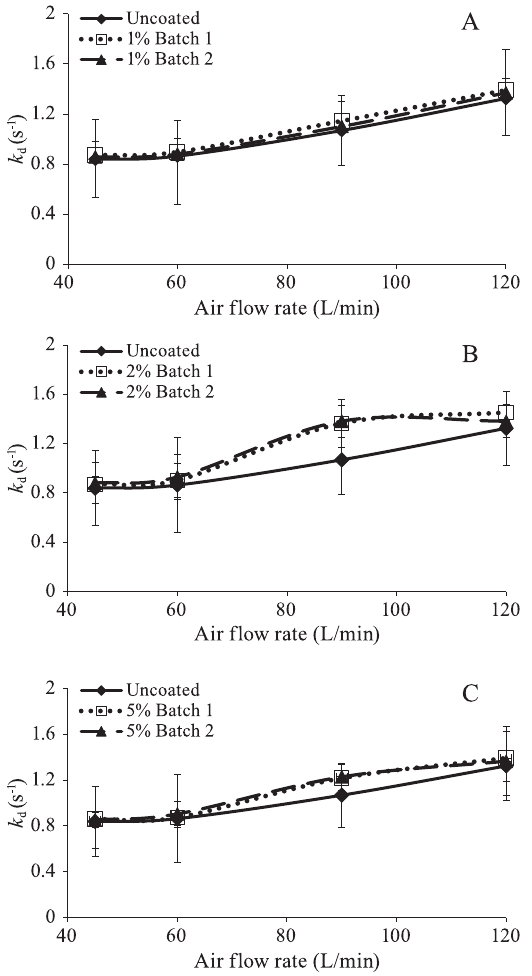
Fig. 4 The de-agglomeration rate constant ( k d ) of the uncoated and 1, 2 and 5 % (w/w) magnesium stearate (MgSt) coated salbutamol sulphate for cumulative fine particle mass as a function of flow rate profiles ( n = 5; mean ± Standard Deviation) aerosolized by Rotahaler ®